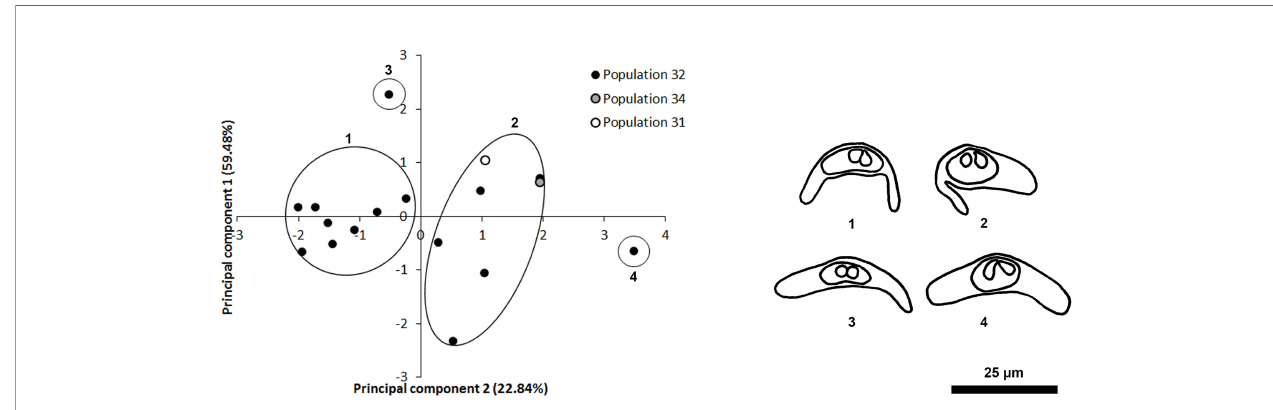
FIGURE 2 | Principal Component Analysis (PCA) of Ceratomyxa spores found in marine fi sh populations. Drawings for four morphologically distinct Cetatomyxa spores are provided in congruence with the PCA analysis. Principal Component 1 (spore length) explained 59.48% of variation, while Principal Component 2 (polar capsule width) explained 22.84% of variation. Scale bar = 25